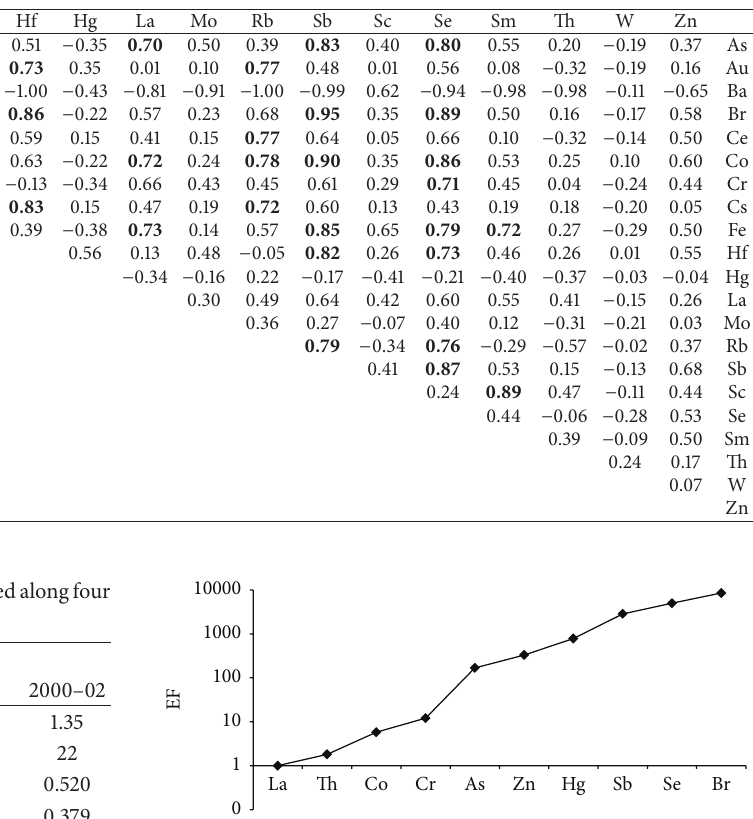
Figure3: EFsofselected elements inPM 2.5 fractioncalculated using La as normalizing